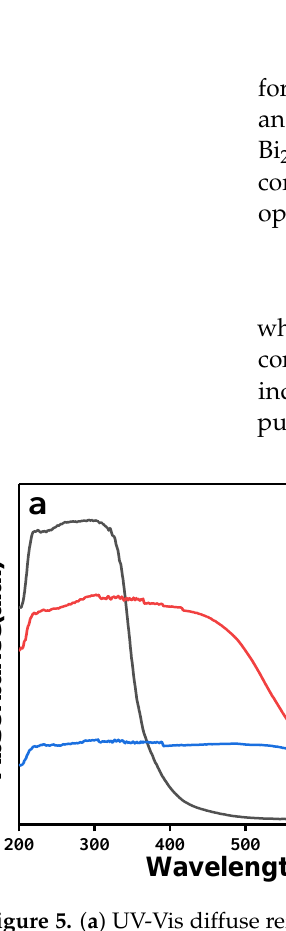
Figure 4. FT- IR spectra of Bi 2 O 2 CO 3 , S2 and S4 (pure BiOI) samples.